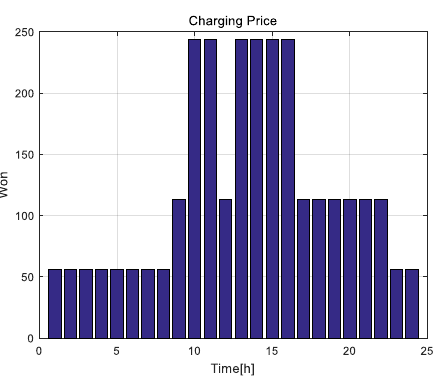
Figure 10. TOU Electricity Charging Rate.